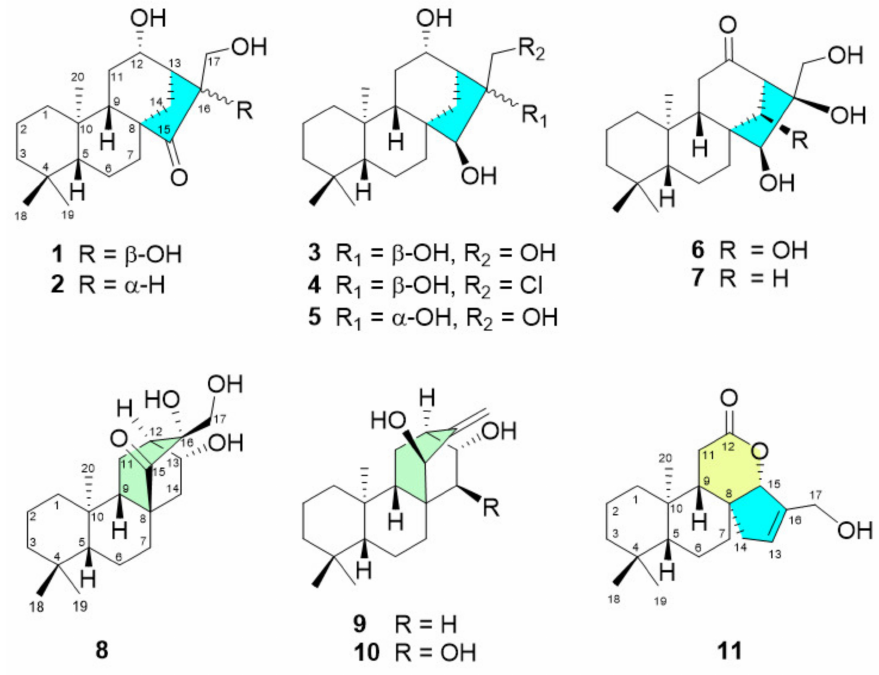
Figure 1. Structures of the isolated diterpenes 1 – 11 from the methanolic extract of M. procumbens